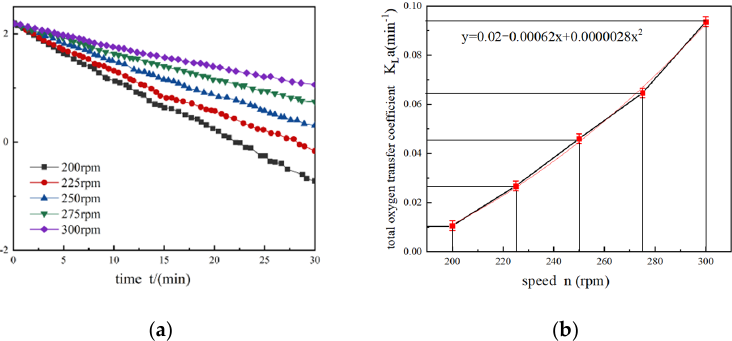
Figure 10. The logarithmic oxygen deficit and total oxygen transfer coefficient at different speeds: ( a ) logarithmic oxygen deficit; ( b ) total oxygen transfer